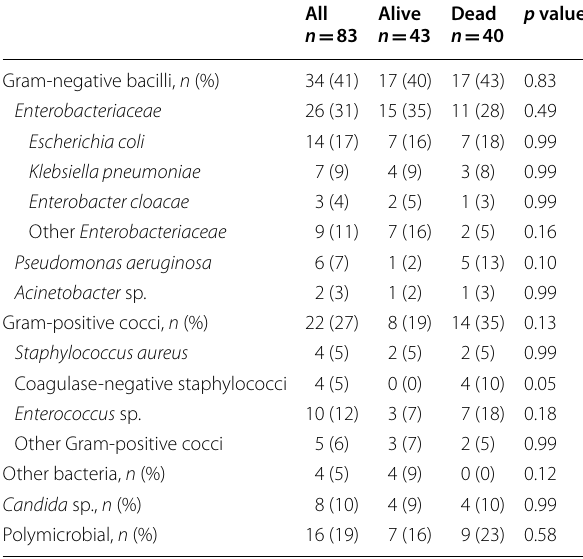
Data are expressed as n